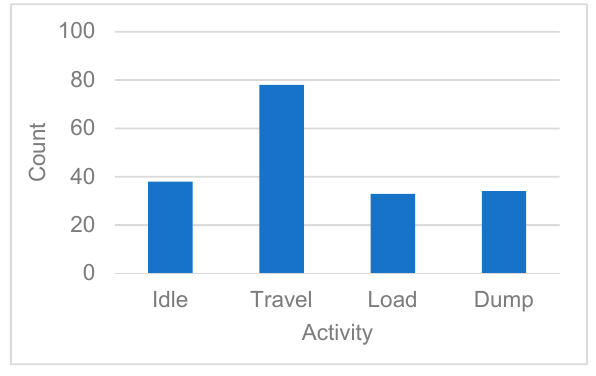
Figure 7. Count of identified activities.